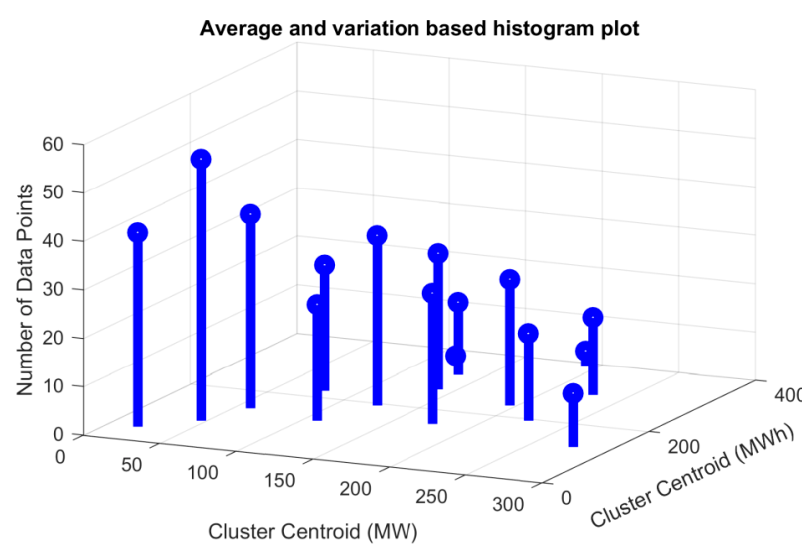
Figure 5. Representative data histogram plot (daily average and variation based).